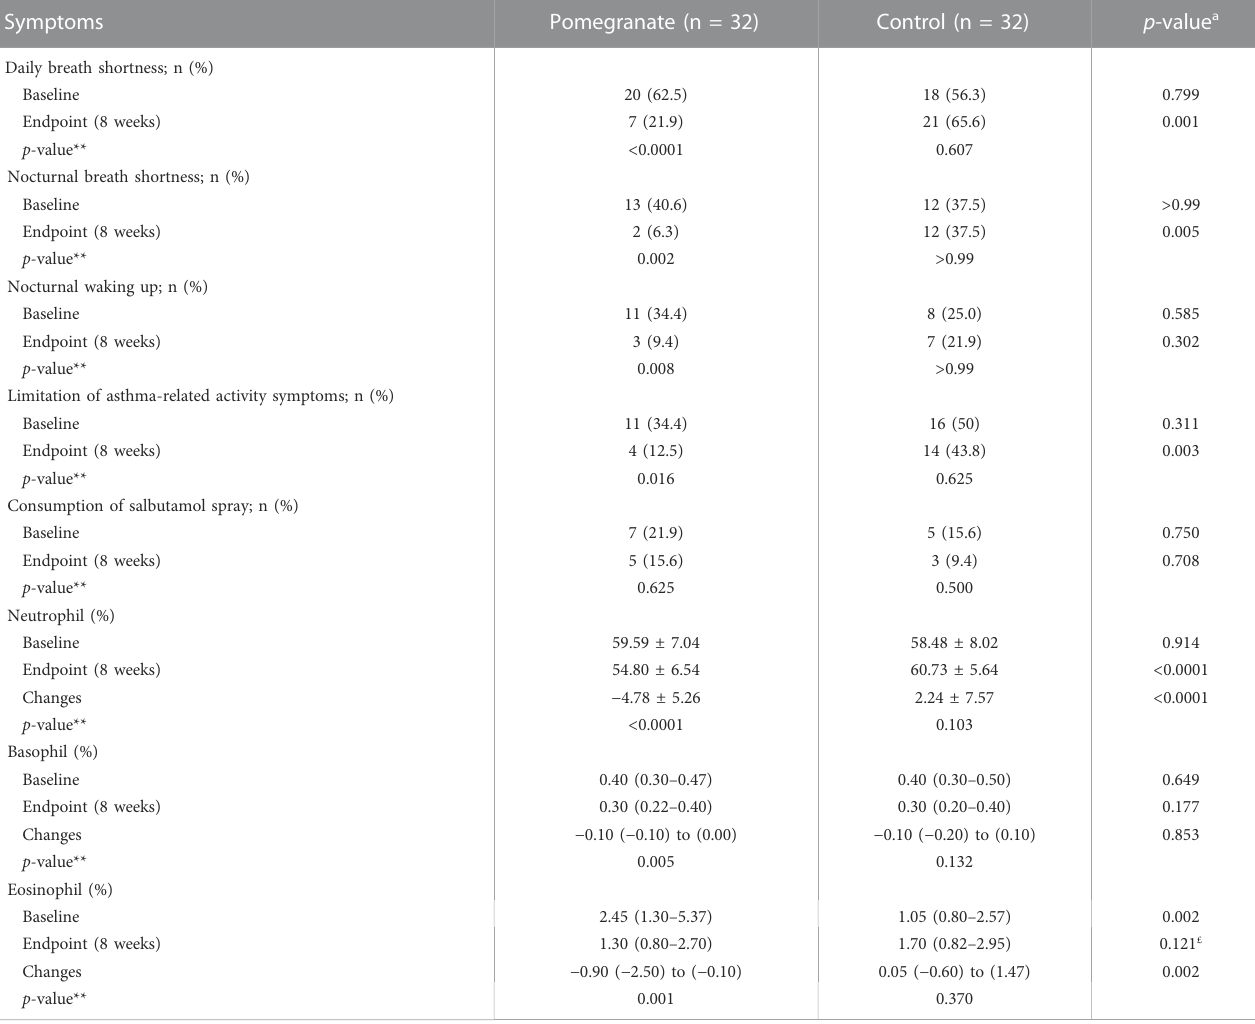
TABLE 3 Comparing clinical changes, basophil, eosinophil, and neutrophil counts between the intervention and control groups. Symptoms Pomegranate (n =